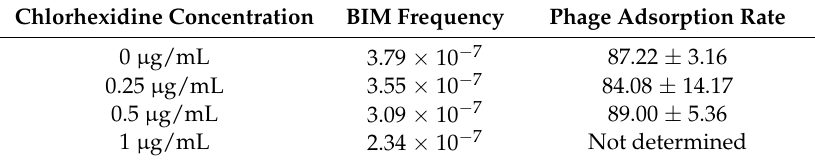
Table 3. Effect of chlorhexidine on frequency of BIMs and phage adsorption rate of phiIPLA-RODI.